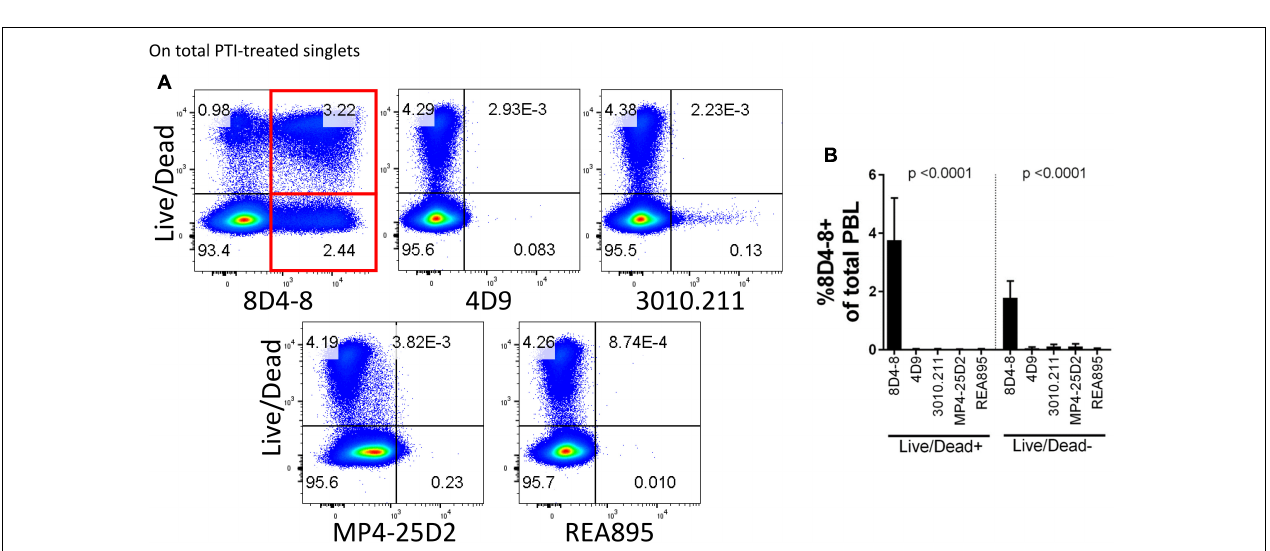
FIGURE 2 | Clone 8D4-8 expression is enriched among Live/Dead + and Live/Dead − cells. PBL were pregated to remove doublets (not shown), and then examined to compare IL-4 expression with Live/Dead following treatment with protein transport inhibitors (PTI). (A,B) Clone 8D4-8 uniquely detects a sizeable population Live/Dead + cells, as well as a subset of Live/Dead − events. In comparison, clones 4D9, 3010.211, REA895, and MP4-25D2 show negligible binding among Live/Dead + / − events. Data shown are representative from 3 experiments from 3 donors. Bars represent mean values and standard deviation. Significance was determined by